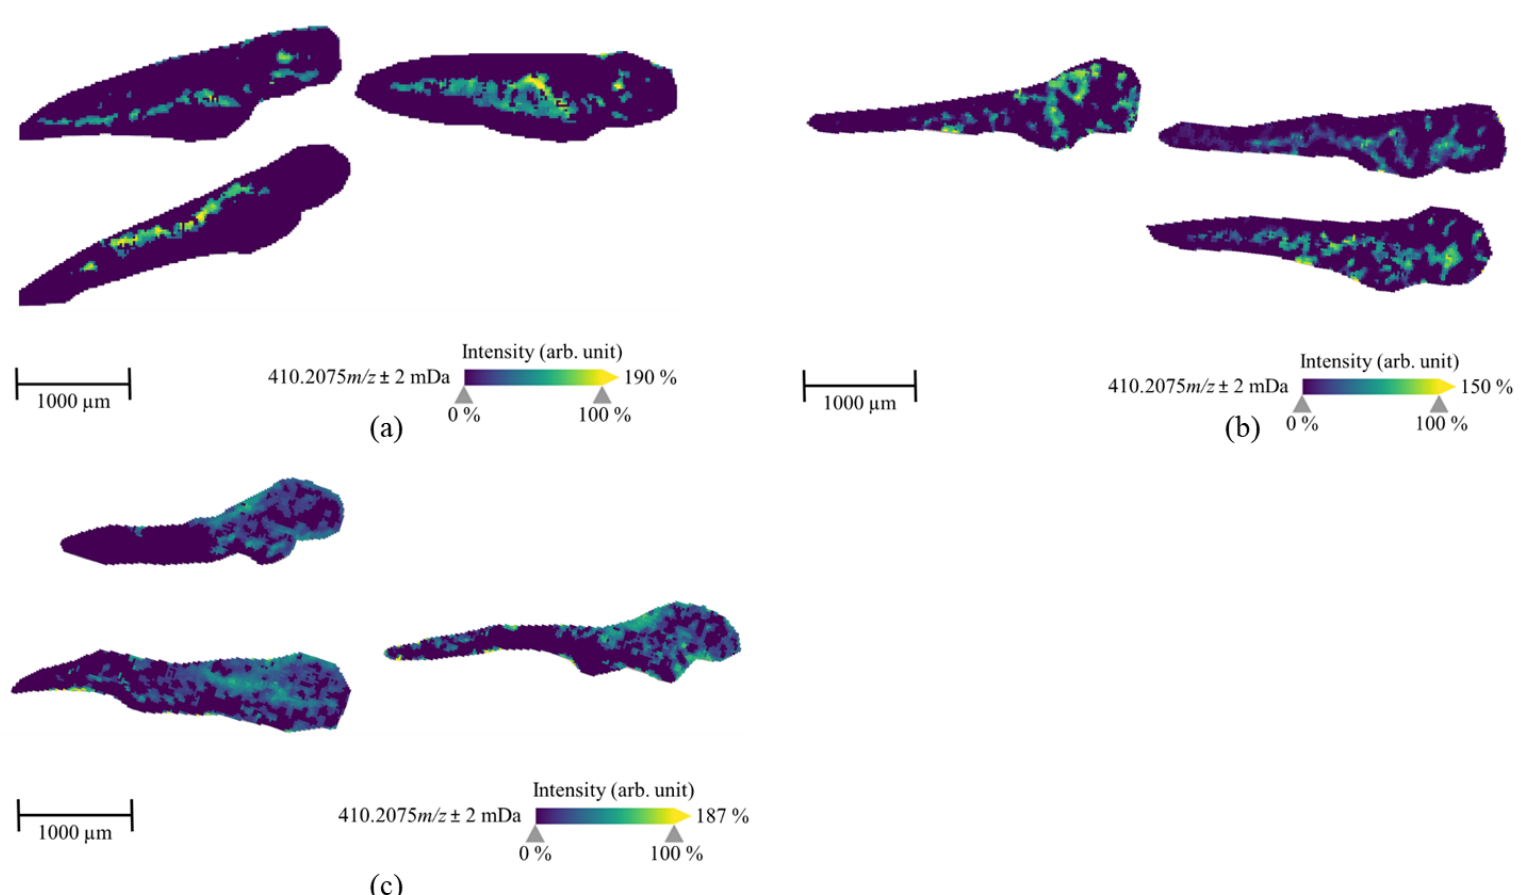
Figure 7. MALDI-MS images of the metabolite M23/M24/M25/M26 (four isomers, m/z 410.2075) in ZF larvae, which were exposed to 7′ N -5F-ADB via microinjection into caudal vein ( a ), heart ventricle ( b ), and hindbrain ( c ) and then incubated at 28 °C for 1 h. These isomeric metabolites were the third most abundant in microinjected ZF larvae except ZF larvae treated through the yolk sac compartment. However, they cannot be differentiated in MSI due to lack of chromatographic separation. The presented sections originate from one representative larva per condition. The images were generated by preparing a colormap from blue (no detection) to yellow (high local concentration), and images were further processed by weak denoising in 96 dpi resolution with 24-bit color.